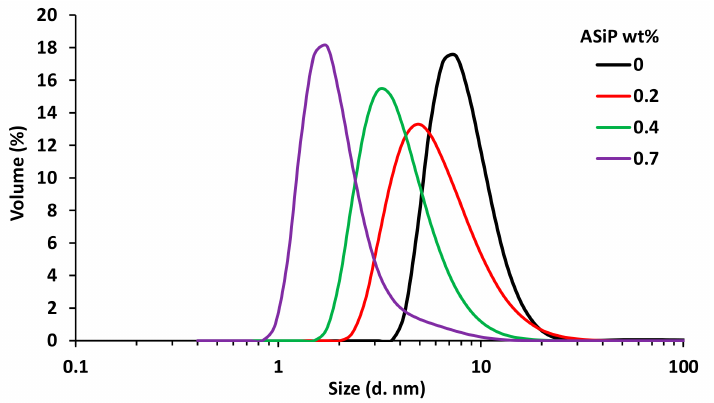
Figure 7. Particle size distribution in the environment of